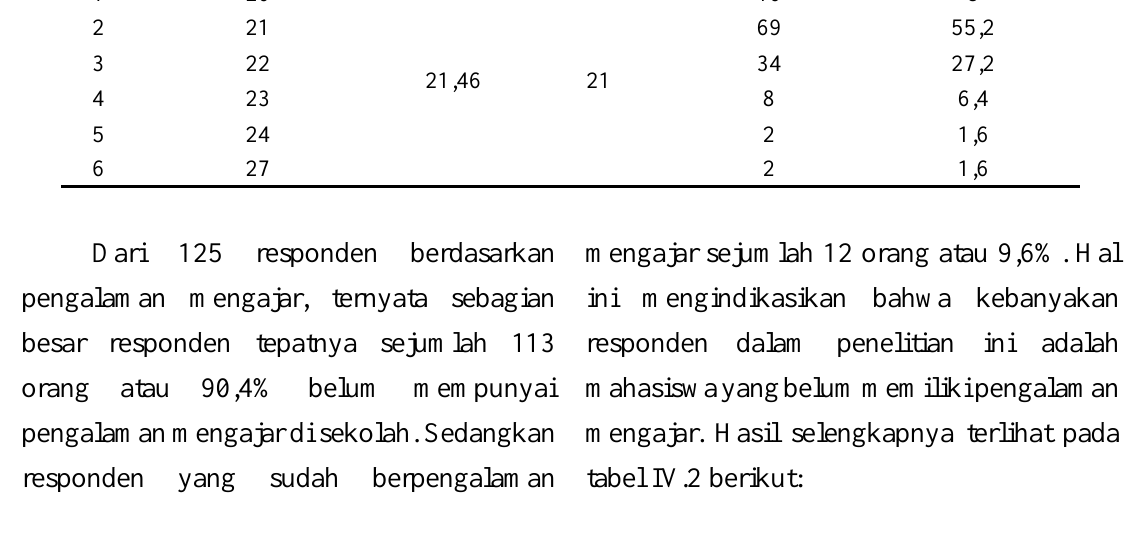
Tabel IV.2. Responden Berdasarkan Pengalaman